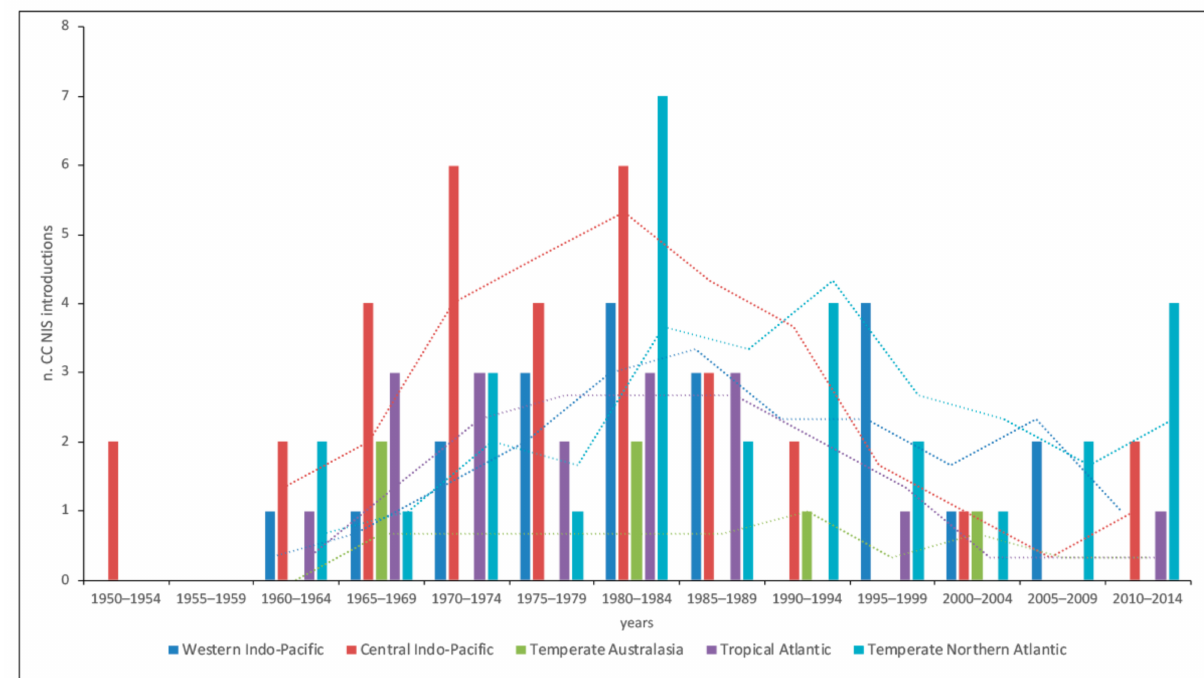
Figure 3. Temporal trends of new marine CC NIS introductions in Europe per 5-year intervals, whose native distribution corresponds to at least one of the five most important realms of Mediterranean CC NIS’ native distribution ranges for the time period 1950–2014 (dashed lines: mobile averages over 3-year period).